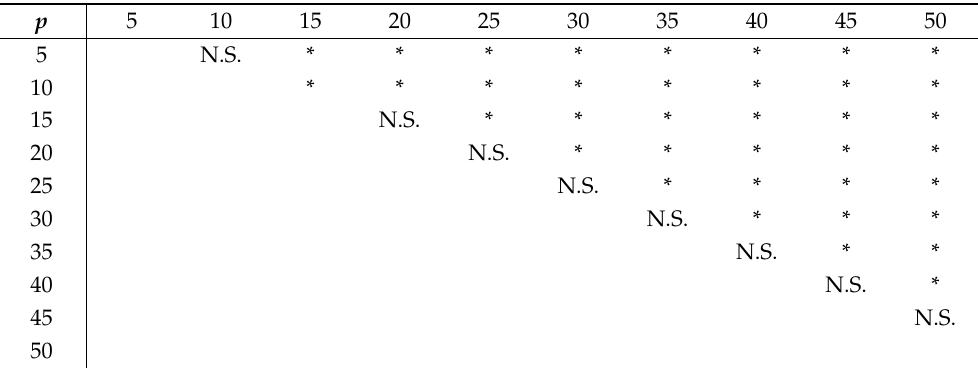
Table 10. Statistical significance in dryness perception for samples with a w value of 50 µ m for various p values. * Significance level < 0.05. N.S. means not